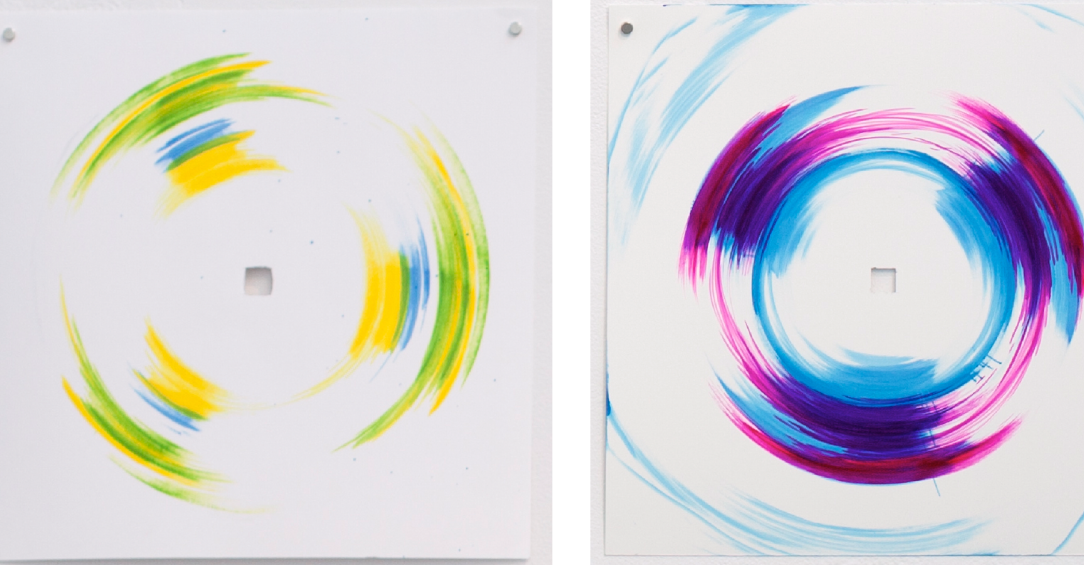
Figure 12 | Ventilator Drawing Nr.